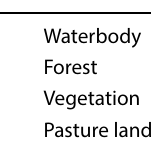
Table 2 Defined classes for land-use